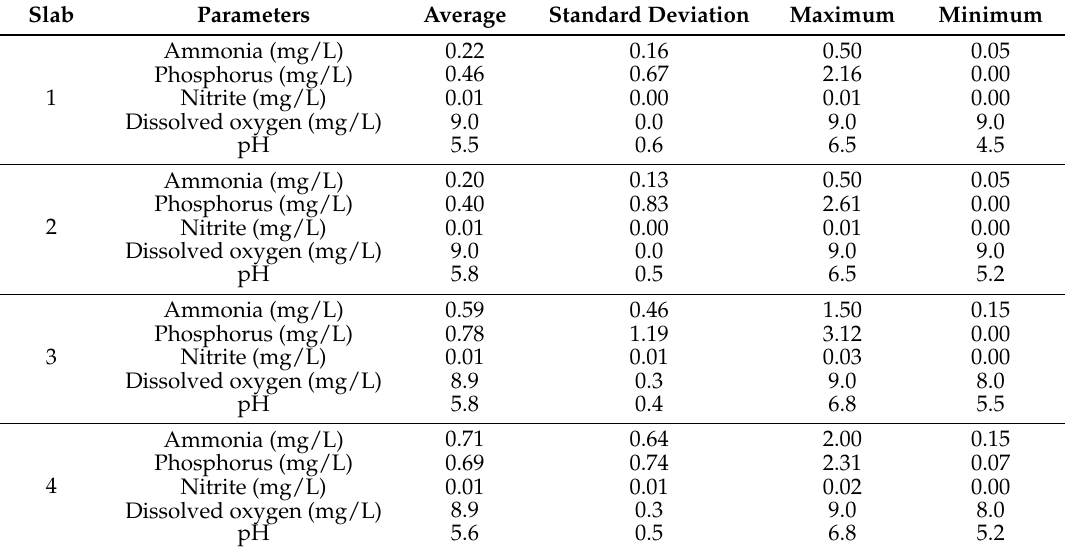
Table 6. Rainwater quality after infiltration through the draining asphalt concrete slabs. Slab Parameters Average Standard Deviation